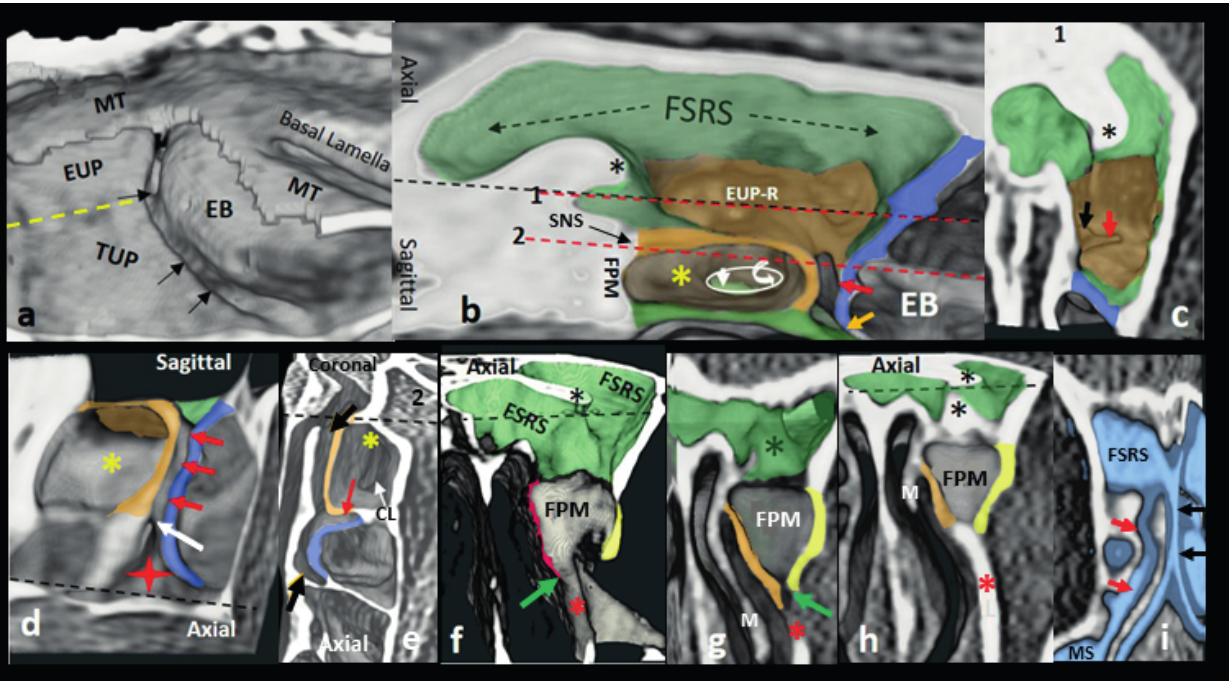
Figure 1. Standard IS-EUP with a singular space at the agger nasi (the “simple ANC”). a. 3D obliqued sagittal image of the right anterior ethmoid viewed from medially, status post subtotal middle turbinectomy (remnants: MT). Demonstration of the two segments of the Uncinate Process (EUP, TUP; plane of separation: yellow dashed line). Black arrows: hiatus semilunaris. b. 3D medial obliqued axial plane above, and sagittal below black dashed line. The roof of the IS-EUP (gold outline) is the floor of the FR (IS-EUP-R), and extends from anteriorly at the SNS, posteriorly to the bulla lamella (blue outline), and laterally to the lamina papyracea (LP). Note the opening in the base of the anterior-superior “cavity” of the IS-EUP, formally known as agger nasi cell (white oval), and it’s with the posterior TI (curved white arrow, gold arrow), as well as the communication with the TI (white arrow). Red arrow: ethmoid infundibulum; gold arrow: turbinal Infundibulum; light green outline: FSRS; dark green outline: TUP; red dashed line 1: plane of axial image, fig. c; red dashed line 2: plane of axial image, fig. e. c. 3D axial view from above displays the FSRS floor (FS-light green, and FR-gold outlines). The border between the green and gold outlines represents the separation between FS and FR. Note the direct opening into the MM (black arrow), and the direct opening into the EI (red arrow). d. 3D obliqued sagittal plane, showing the direct communication of the FSRS with the superior EI (red arrows). Note communication of the anterior- superior “cavity” of the IS-EUP (yellow asterisk) with the postero-superior TI (white arrow). Red star: TI. e. 3D axial view from above shows the IS-EUP (yellow asterisk), its relationship with the Bulla Lamella (blue outline), the Common Lamella (CL), and the Middle Meatus (black arrows). f.-h. Obliqued 3D coronal/axial images viewed from posteriorly show the “posterior surface” of the Frontal Process of the Maxilla (FPM), with a bony ridge (black asterisk) creating two inferior segments in the FS (green outline). Note site of attachment to the medial FPM by the Uncinate Lamella (gold outline), the lateral attachment by the Lamina Papyracea (yellow outline) the horizontal plane of the Fronto-Nasal-Maxillary Suture/SNS (red asterisk); antero-inferior site of fusion by UL/LP/Lacrimal bone (red asterisk) (green arrow); Middle Turbinate (M). i. 3D obliqued coronal/sagittal view shows the air spaces (blue outlines) within the anterior ethmoid sinus, the FSRS, and the draining channels: the Ethmoid Infundibulum (red arrows); and the Middle Meatus (black arrows), both directly communicating with the FSRS. Maxillary Sinus